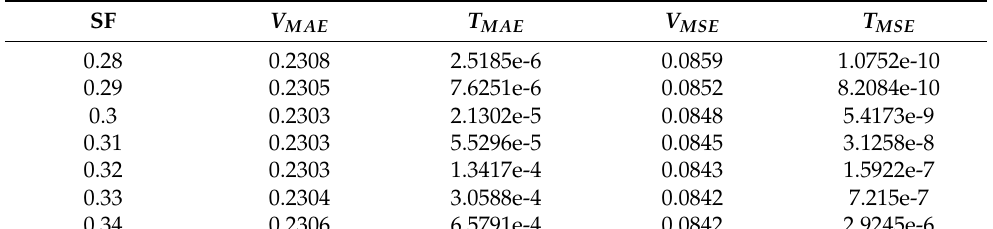
Table 2. Measured training and validation performance.